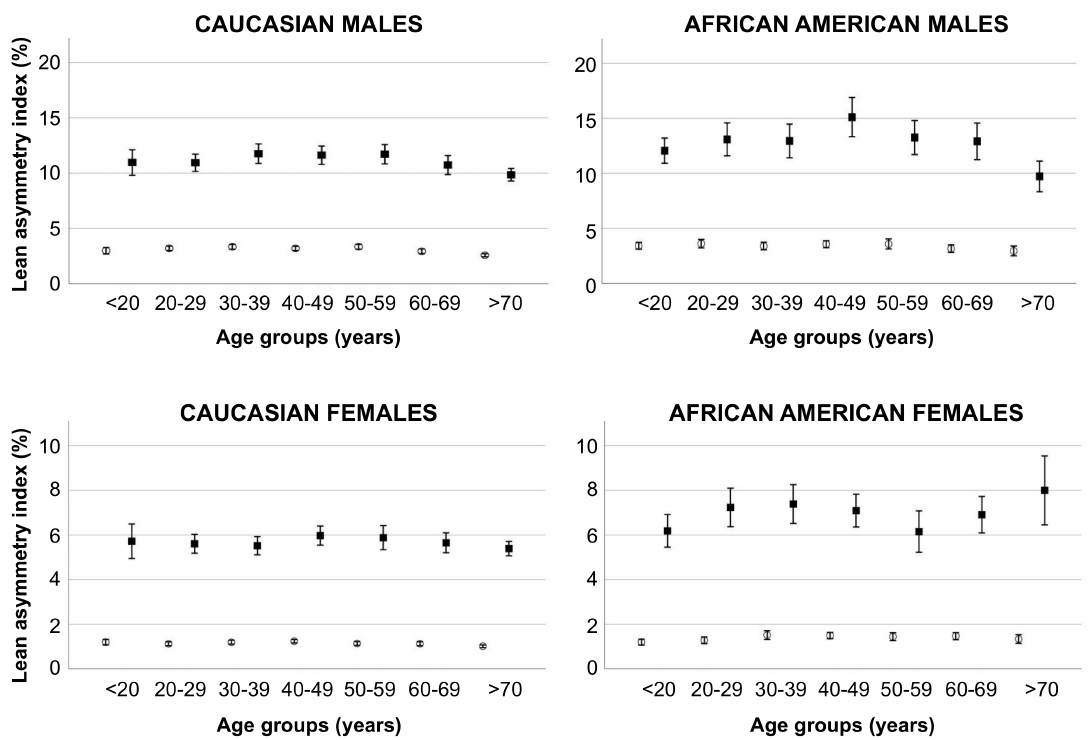
Figure 4. Mean values of the lean asymmetry index for the upper limb (white circles) and lower limb (black squares) according to the age group in males (top panels) and females (bottom panels) of the two ethnic groups. Error bars indicate 95% confidence